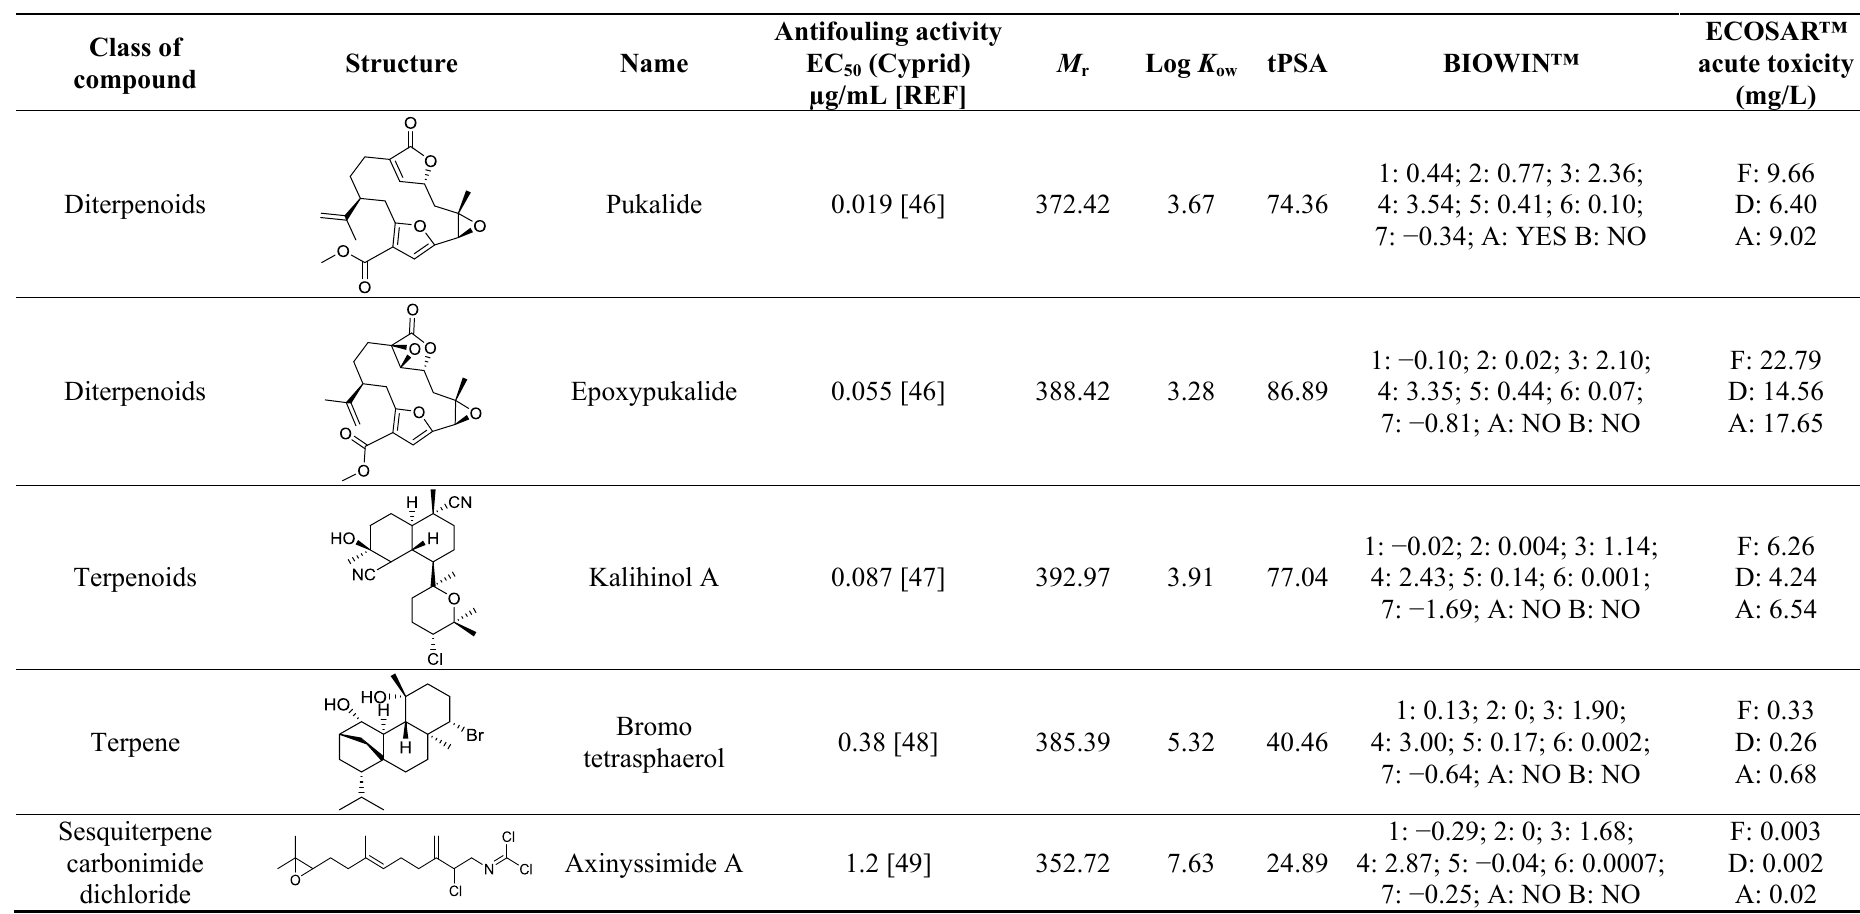
Table 7. Natural products, M < 400, with anti-fouling properties. EC r prevented; M = molecular weight; tPSA = total polar surface area; Log K r were calculated using KOWWIN™. BIOWIN™ models: 1-linear, 2-non-linear, 3-ultimate, 4-primary, 5-linear MITI, 6-non-linear MITI, 7-anaerobic; Criteria A-model 2 or 6 > 0.5 and model 3 > 2.2; Criteria B-model 3 “weeks” or faster and model 5 > 0.5. ECOSAR™: F = fish, D = daphnid, A = green